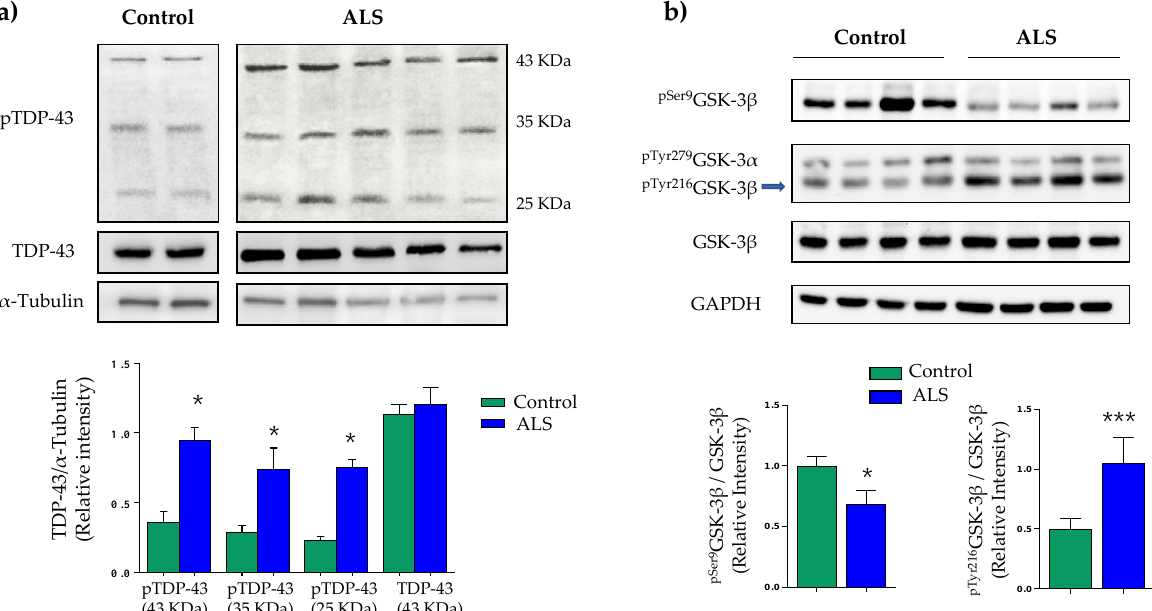
Figure 1. TDP-43 phosphorylation and GSK-3 β activity in control and ALS lymphoblasts. Immortalized lymphocytes from control and ALS individuals were seeded at an initial density of 1 × 10 6 × mL − 1 in RPMI medium containing 10% FBS. Twenty-four hours after seeding, cells were harvested and processed for Western blotting analysis. ( a ) A representative blot showing levels and phosphorylation status of TDP-43. ( b ) Whole cell extracts were used for the determination of relative levels of phospho-GSK3 β (Ser9 and Y216) and total GSK-3 β by Western blotting. Densitometric analyses below represent the mean ± SEM of different observations carried out in five cell lines from each group (* p < 0.05, *** p < 0.001 significantly different from control cells).